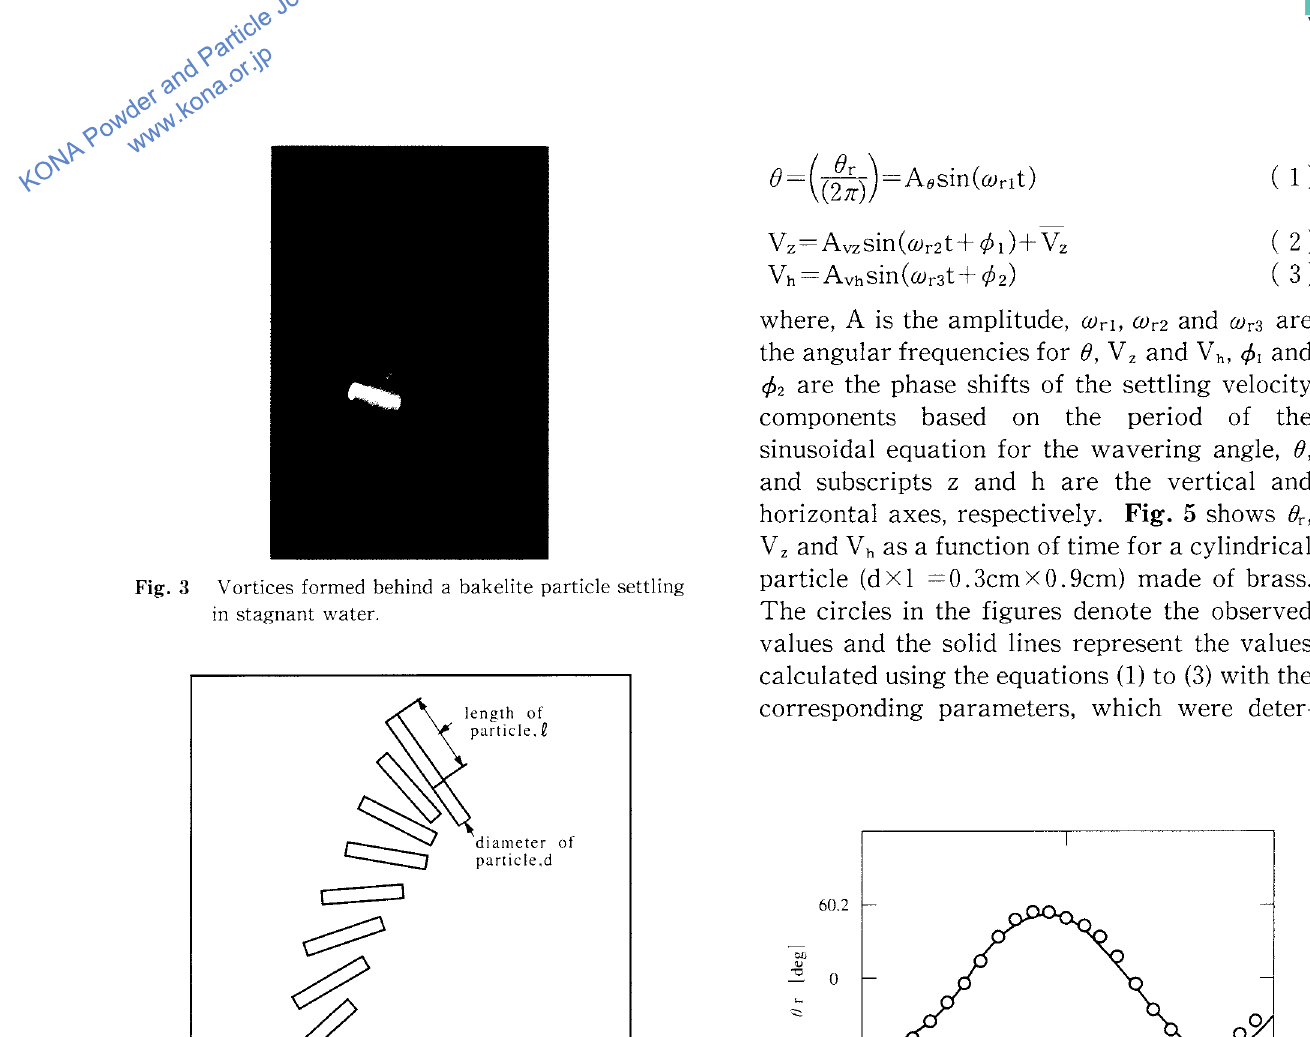
Fig. 3 Vortices formed behind a bakelite particle settling in stagnant water.